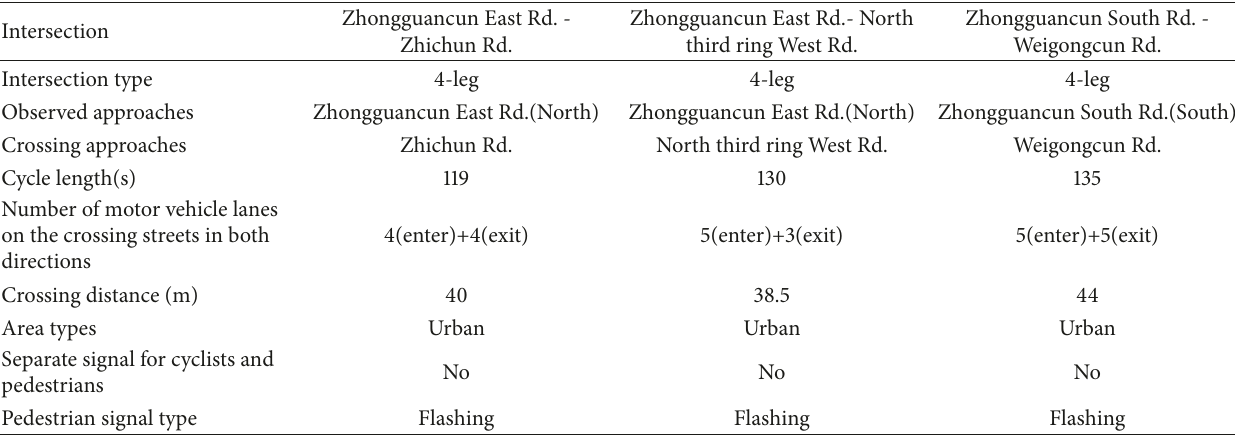
Table 1: Characteristics of the three observed